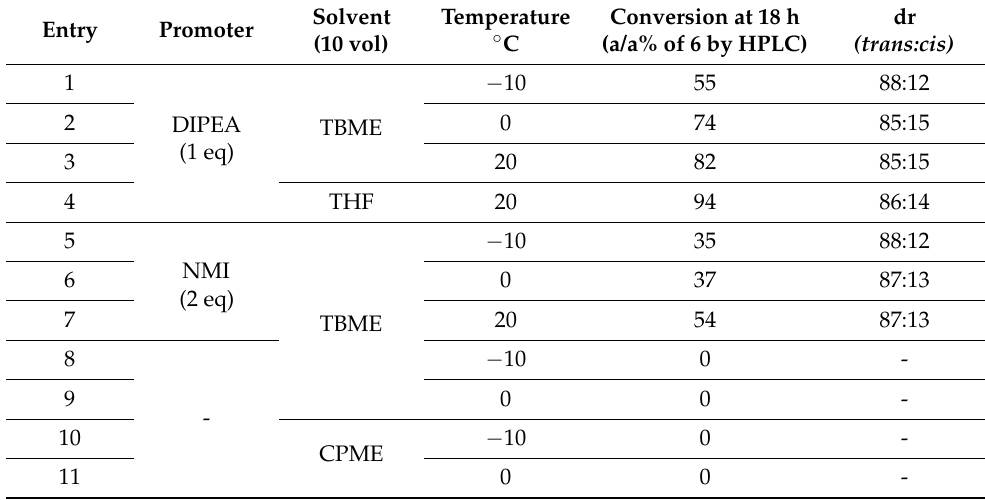
Table 1. Screening of reaction conditions for promoting and suppressing the racemic